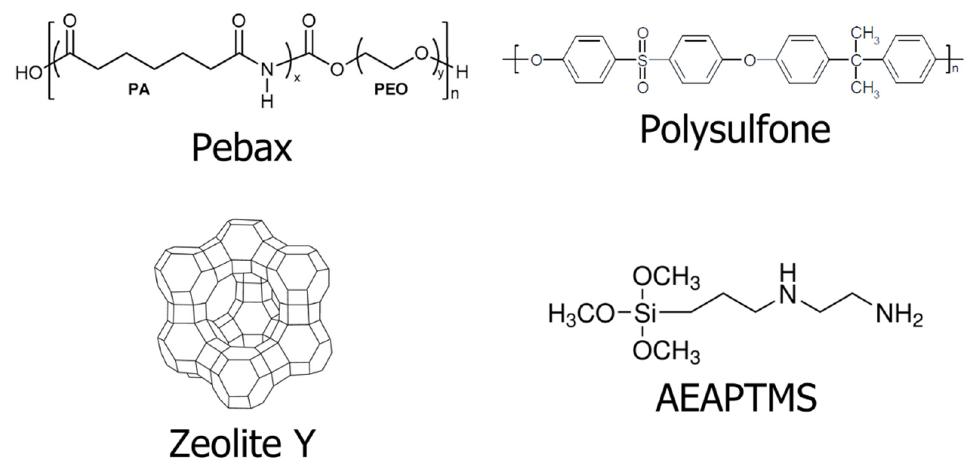
Figure 1. Schema of the chemical structure of Pebax, polysulfone, zeolite Y, and N-[3-(trimethoxysilyl)propyl]ethylenediamine (AEAPTMS) used in this study.